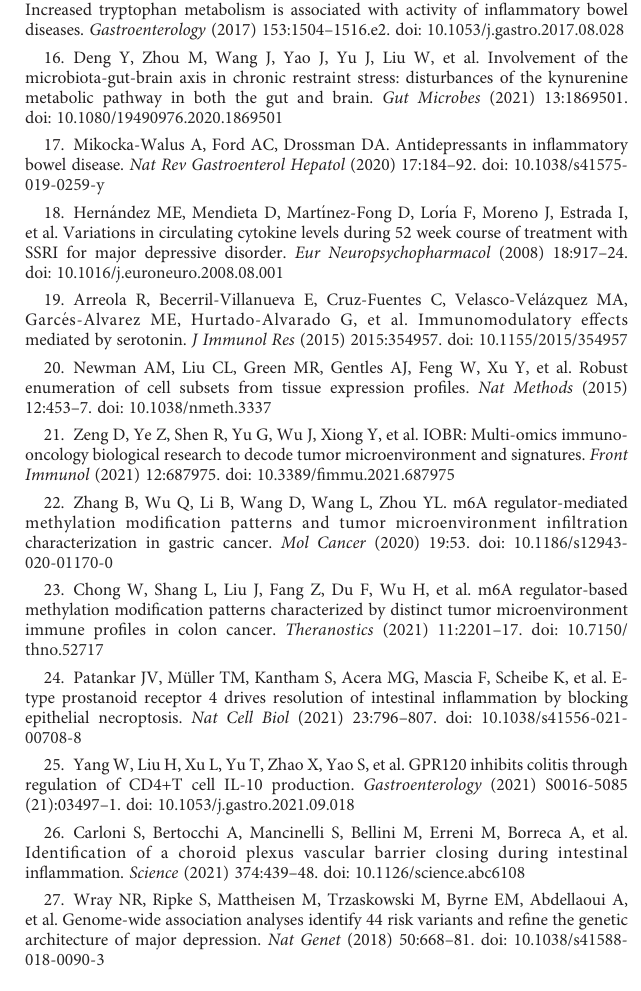
SUPPLEMENTARY FIGURE 1 Unsupervised clustering of two molecular subtypes by 33 core genes in the meta-GEO cohort (A) The interaction of expression of 33 core genes in IBD. (B) Bar plot shows the GSVA score of representative Hallmark pathways